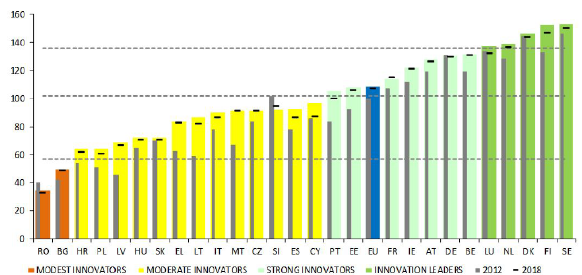
Figure 3. Performance of EU Member States’ inno- vation systems, source: EU